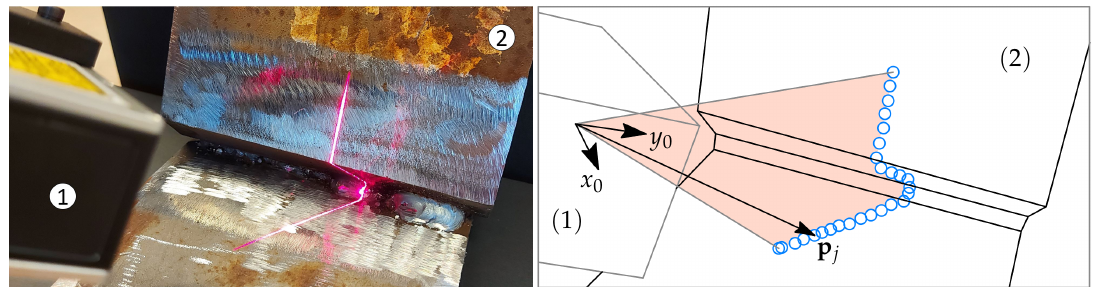
Figure 1. A commercial laser triangulation sensor (1) pointing at the weld groove of a test object (2). A local sensor fixed frame is denoted Frame 0 and all data points p j are obtained in the coordinates of Frame